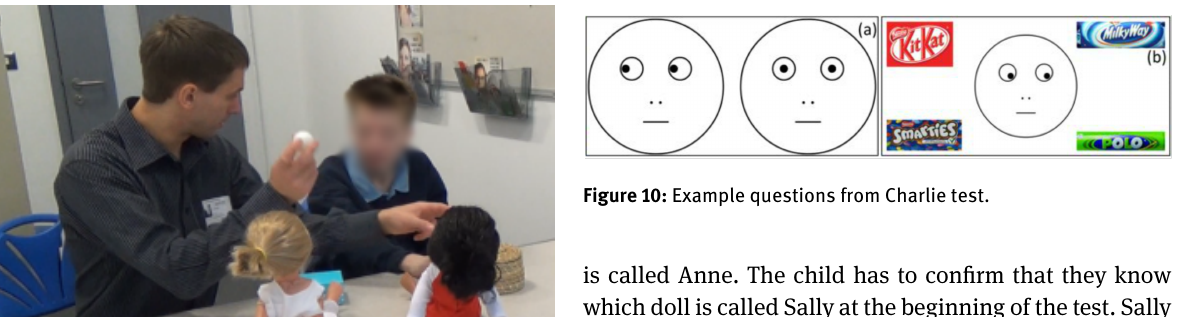
Figure 9: Child participating in the Charlie test.